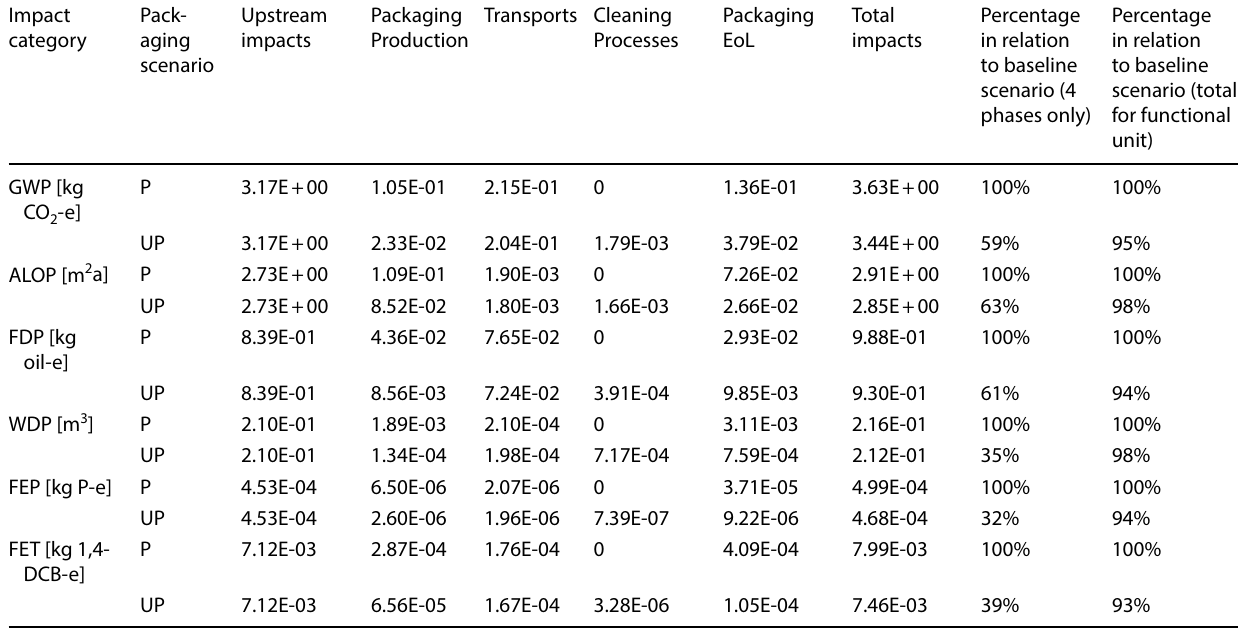
Table 1 Environmental impact of the packaging scenarios P (packed) and UP (unpacked) within the six impact categories cli- mate change (GWP), agricultural land occupation (ALOP),